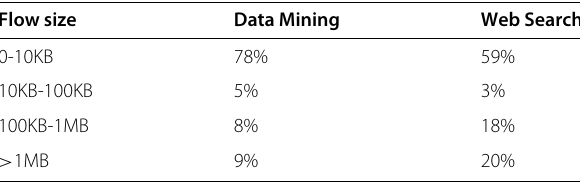
Table 2 Flow size distribution under data mining and web search